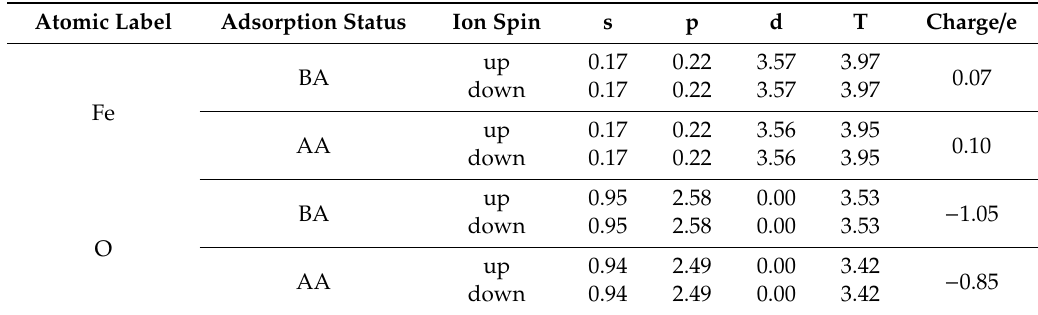
Table 4. Mulliken charge populations of atoms for H 2 O / IS.